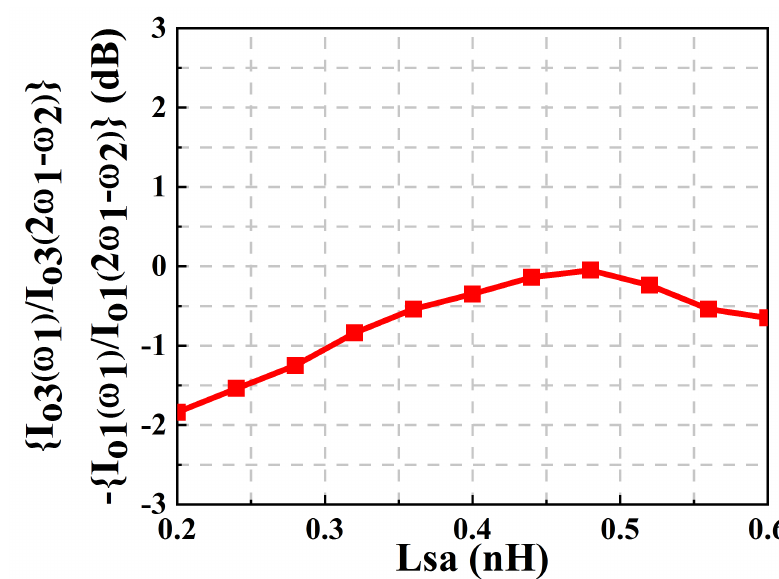
Figure 10. Linearity analysis at the drain node transistor of M 1 and M 3